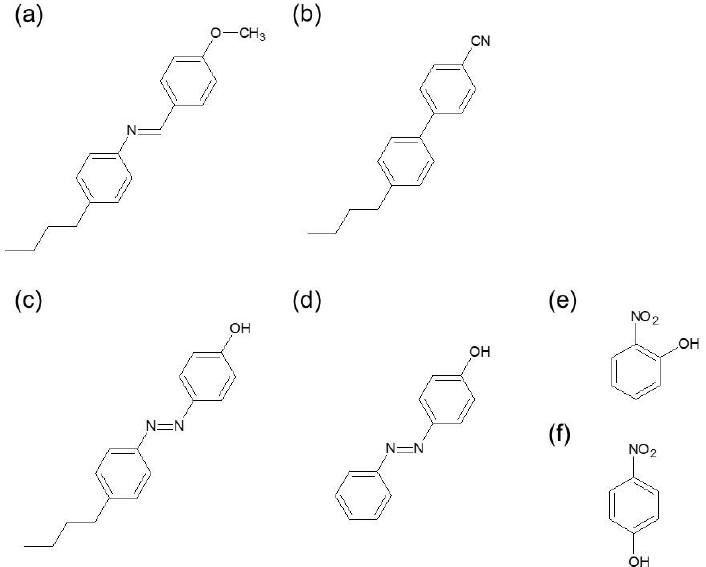
Figure 1. The molecular structures of the LCs and photo-responsive guest molecules are shown: ( a ) 4-methoxybenzylidene-4-n-butylaniline (MBBA), ( b ) 4-cyano-4-pentylbiphenyl (5CB), ( c ) 4-hydroxyazobenzene (PPAP), ( d ) 4-butyl- 4′ -hydroxyazobenzene (BHAB), ( e ) 2-nitrophenol (o-NP), and ( f ) 4-nitrophenol (p-NP).